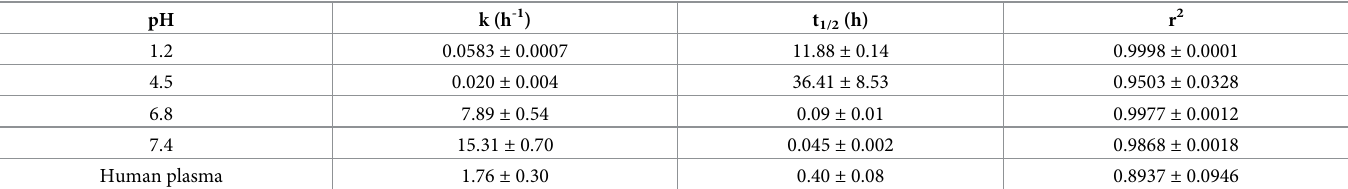
Table 2. Pseudo-first-order kinetic parameters for hydrolysis of CUR-2GE at 37˚C in buffers at pH 1.2, 4.5, 6.8 and 7.4 and human plasma.